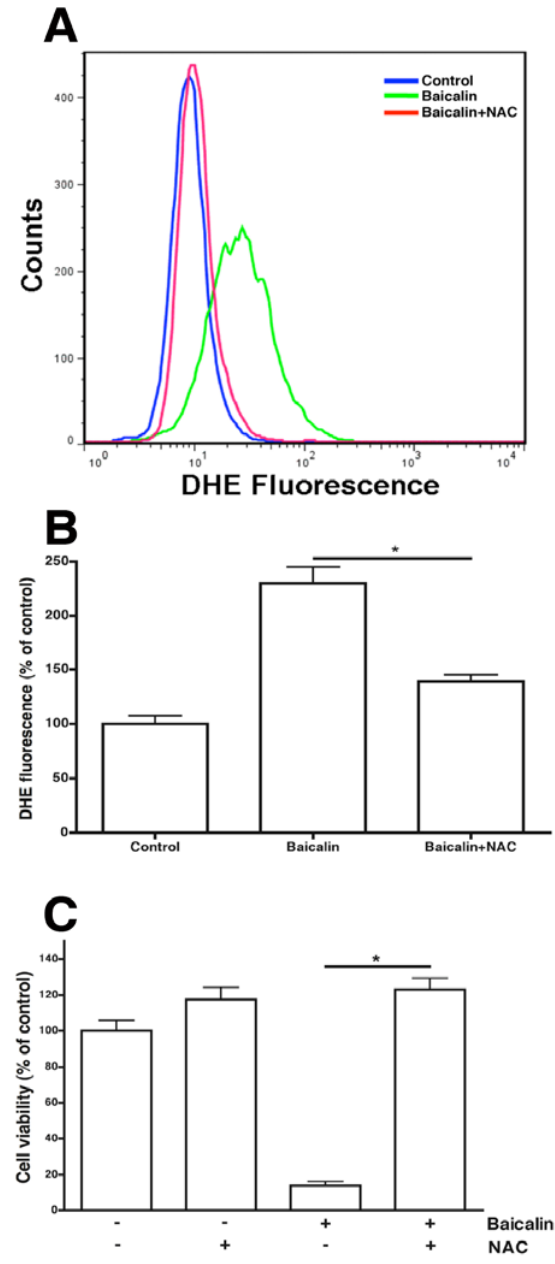
Figure 6. Effects of NAC and ROS production on cell viability. SW620 cells were incubated for 24 h with baicalin (200 µM) and ROS scavenger, NAC (2 mM), as indicated. ( A ) Intracellular ROS levels were quantitated with FACS analysis. FACS profiles for DHE in untreated (vehicle) or baicalin-treated cells (10 5 ) were representative of the three experiments of three replicates. ( B ) The relative percentage of cells that showed detectable ROS production in the cell samples. Control ROS + cells were set at 100. ( C ) Cells were incubated with or without baicalin (200 µM) in the presence or absence of ROS scavenger NAC (2 mM) for 24 h, and the proportion of surviving cells was measured with MTT assay. * p < 0.05, compared to the group treated with baicalin